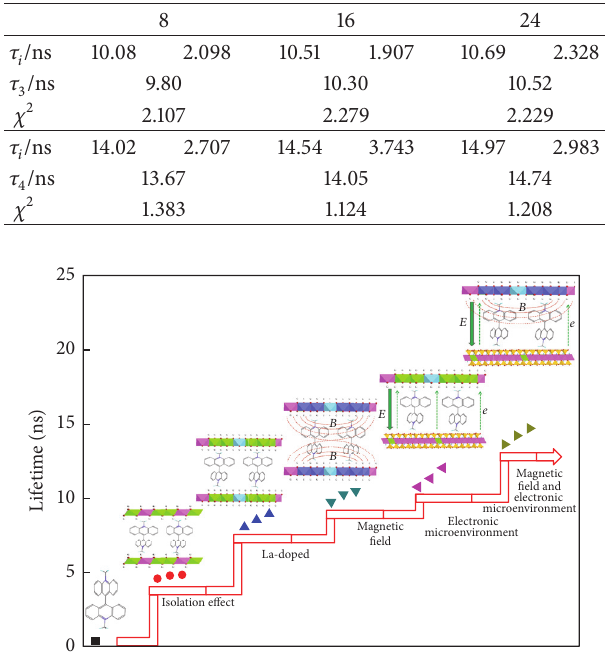
Figure 5: The comparison of BNMA’s lifetimes in the different states under the different environments. Black dot represents the luminescent lifetime of BNMA powder (0.37ns), the red dots stand , and the blue ones show for those of (MgAl-LDHs/BNMA@PVS) n those of Mg( 𝑛 )-films. The dark green dots stand for those of Co( 𝑛 )- films. The pink dots stand for those of MgM( 𝑛 )-films. The green- yellow dots stand for the luminescent lifetimes of CoM( 𝑛